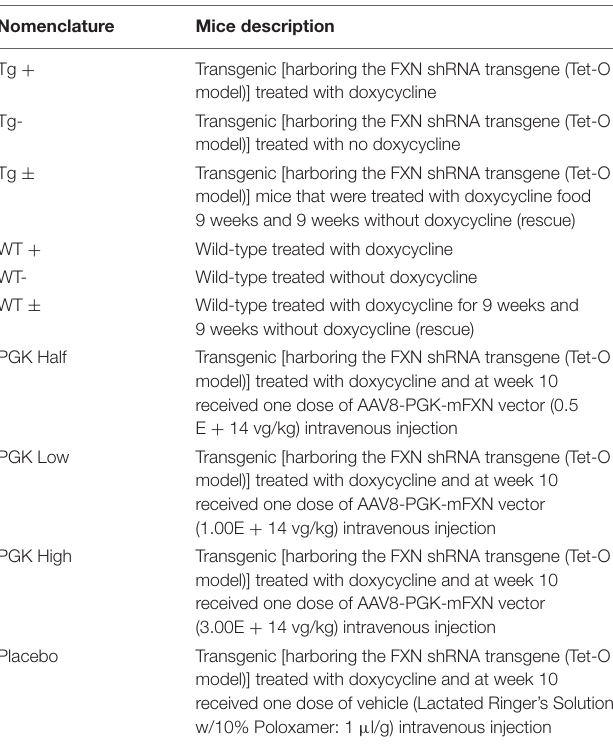
TABLE 1 | Nomenclature and mice